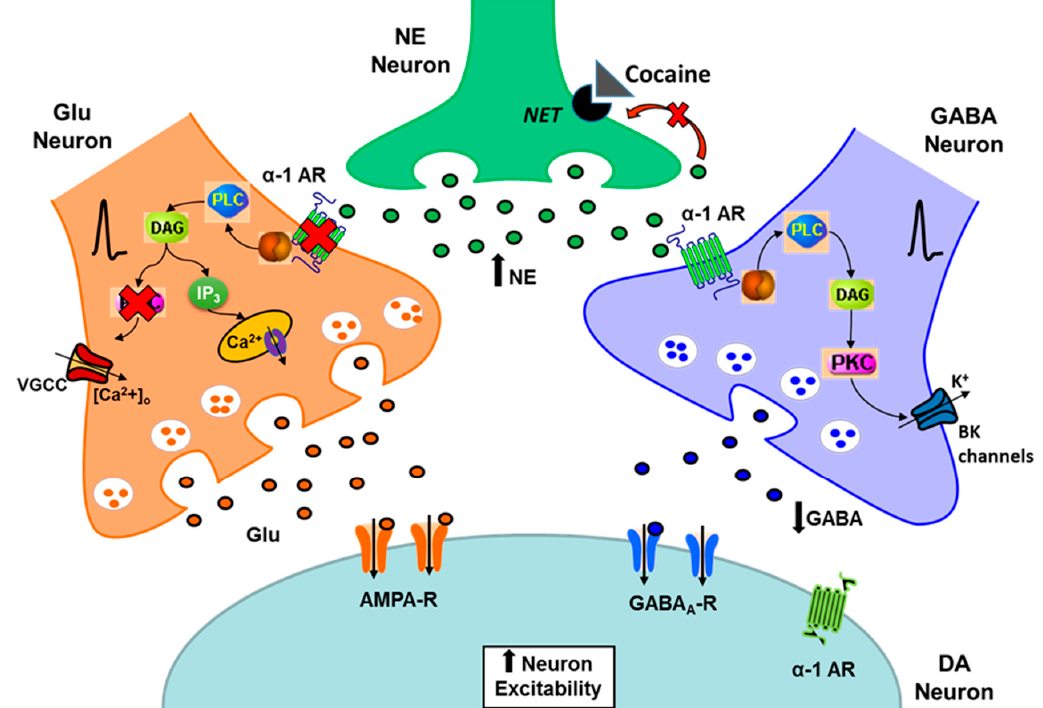
Figure 7. Proposed model for α 1-ARs action on glutamatergic and GABAergic terminals during the initiation and expression of cocaine sensitization. After cocaine sensitization and a withdrawal period, the α 1-ARs present on glutamate terminals on VTA DA neurons are desensitized. In addition, a PKC-mediated increase in glutamate release on VTA DA cells is absent after 5 days of cocaine injections. In contrast, the α 1-AR-mediated decrease on GABA release on VTA DA neurons remains unaltered.